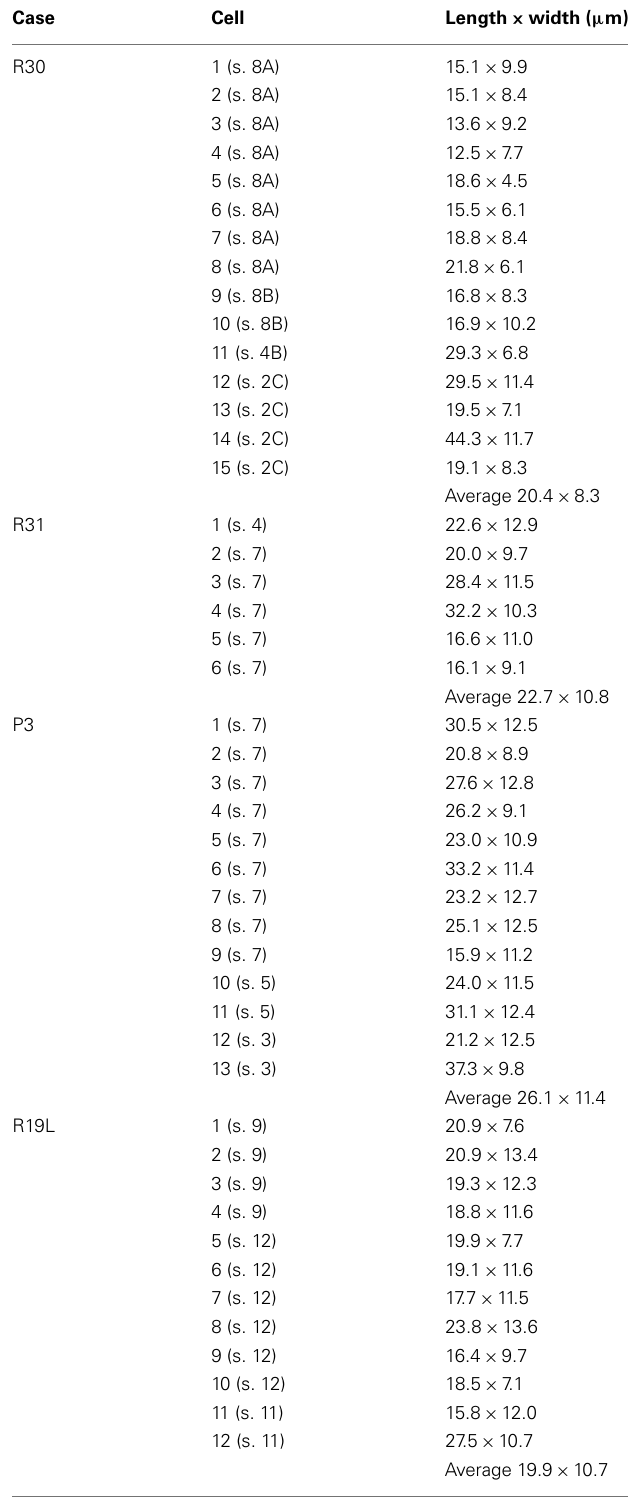
Table 1 | Soma size of NADPHd + intracallosal cells from four